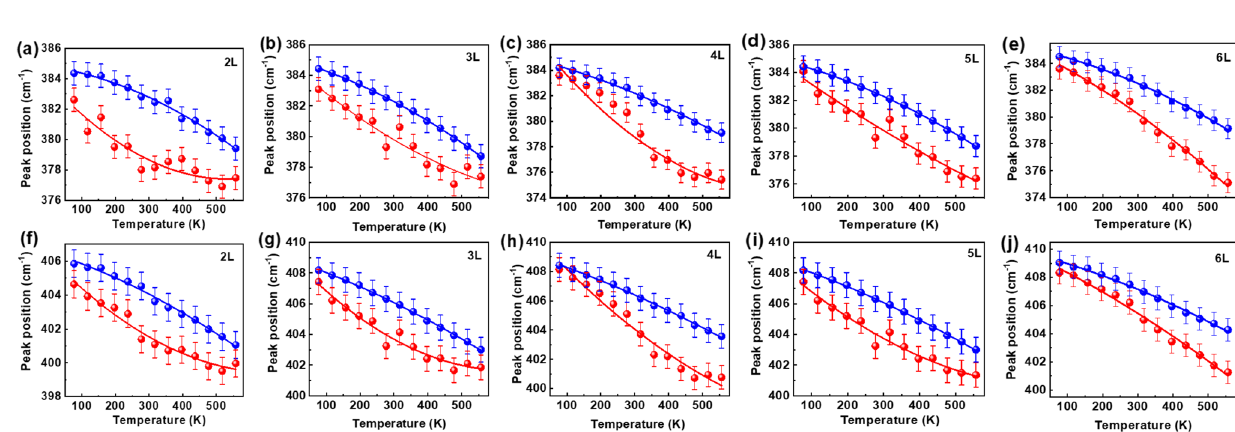
Figure 3. Raman spectra of ( a – e ) supported and ( f – g ) suspended few-layer MoS 2 for different temperatures.